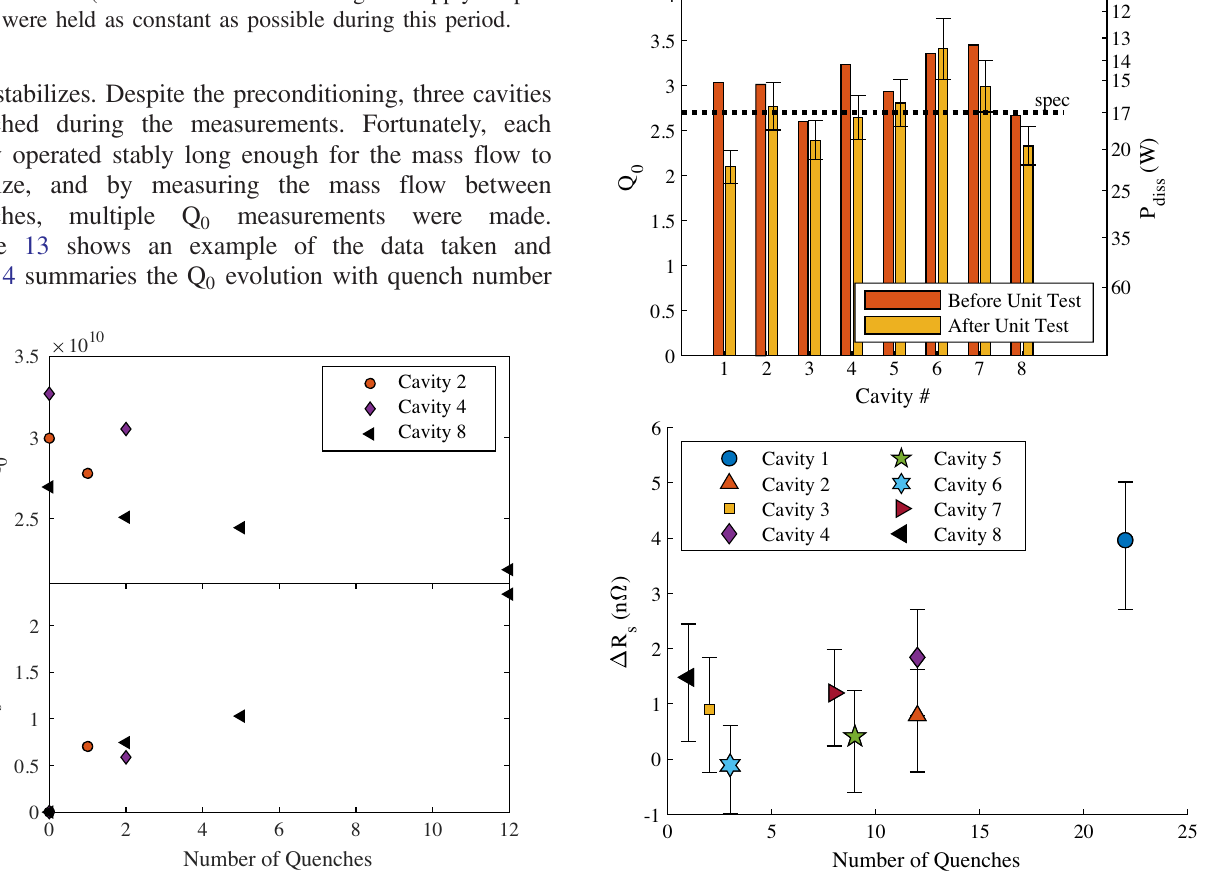
FIG. 14. Q 0 versus quench number for three cavities (top) and the corresponding change in surface resistance relative to zero quenches (bottom). The degradation was recovered after thermal cycling.